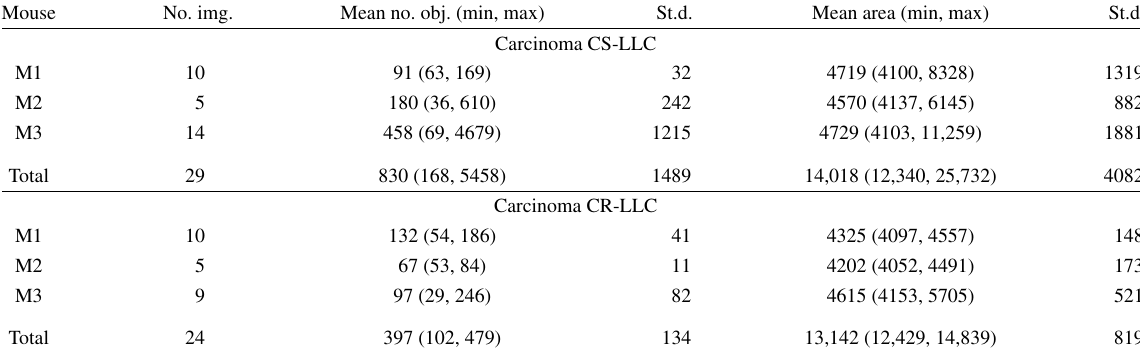
Quantification of TUNEL staining (Cy3 channel) for (a) CS-LLC and (b) CR-LLC